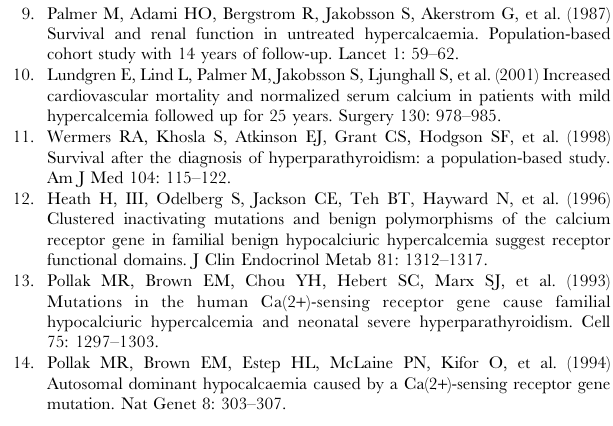
Table S2 Complete list of genome-wide significant SNPs. Below is the list of all SNPs that exceeded the threshold of genome-wide significance (p , 5 6 10e-8). Position is given for NCBI Build 35. Meta-analysis is performed by inverse variance weighted fixed effect regression. The coded allele is the allele to which the beta (effect) estimate refers. Results are shown separately for (A) European and Indian Asian cohorts, (B) European cohorts only, and (C) Indian Asian cohorts only.